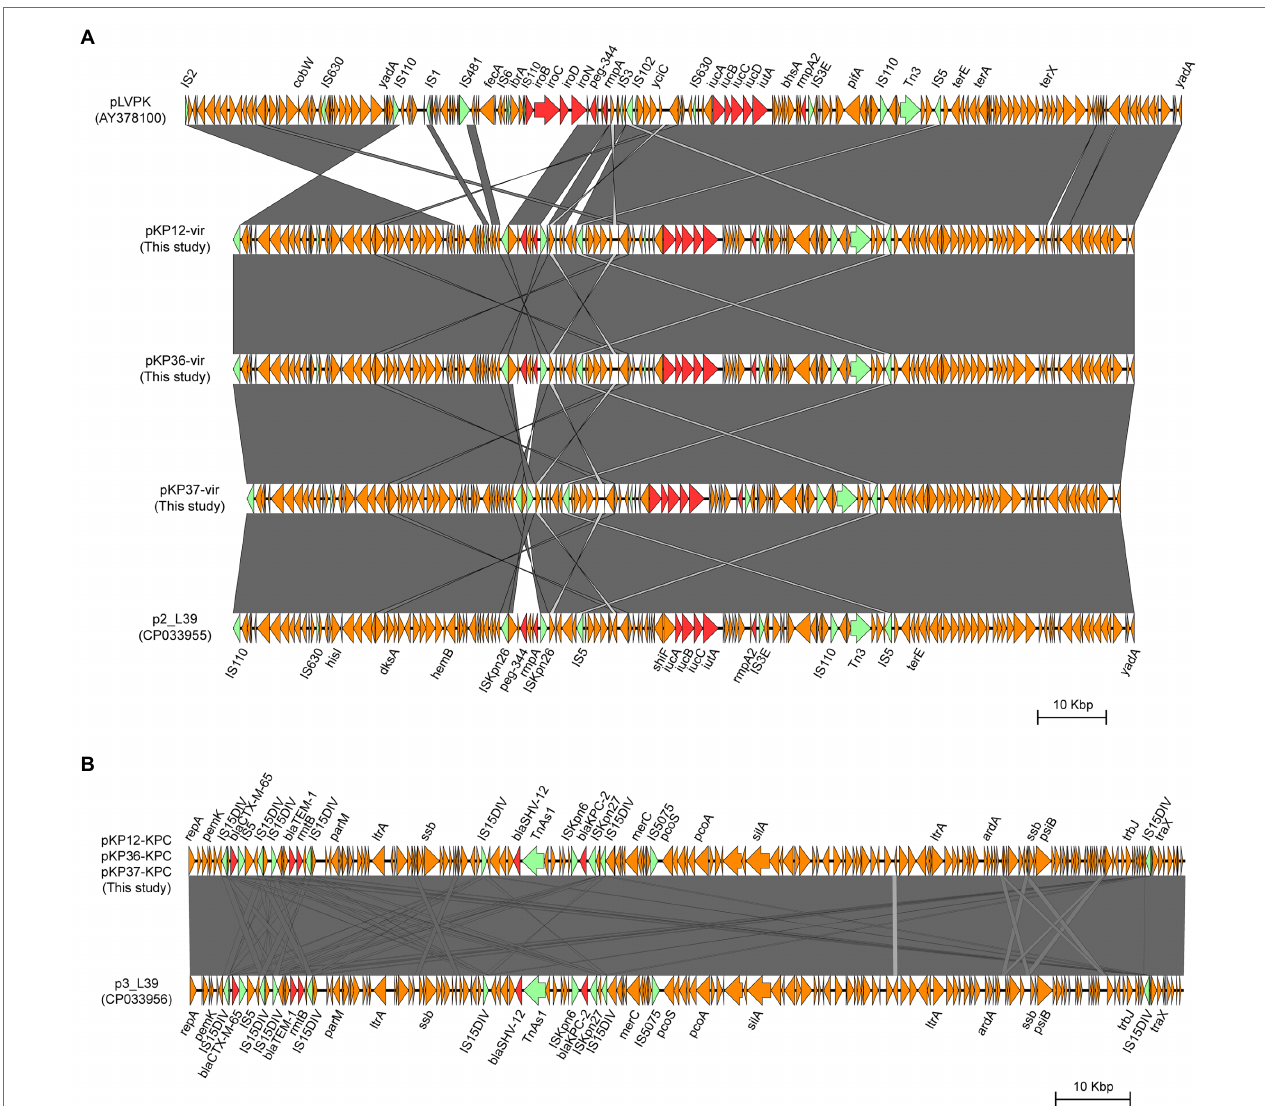
FIGURE 5 | Structural comparison of the genetic context of virulence genes (A) and bla KPC-2 gene (B) in representative plasmids. The arrows represent coding sequences (red arrows, antimicrobial resistance genes or virulence genes; green arrows, mobile elements). Shading denotes the regions with high homology (>95% nucleotide